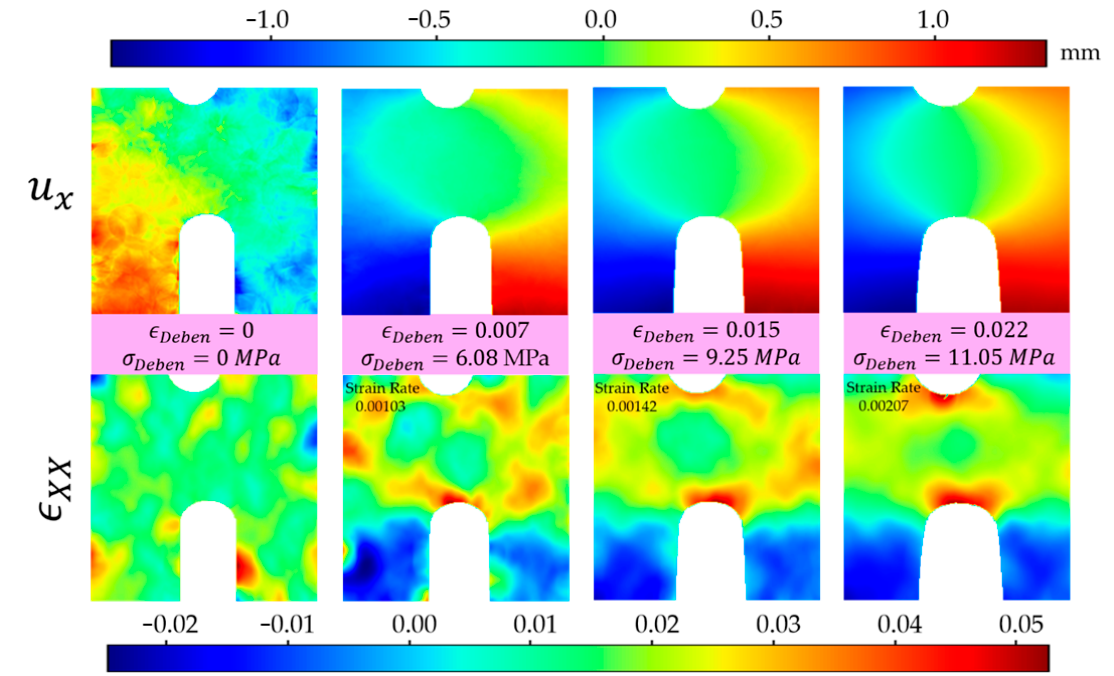
Figure 5. Displacement (top) and stain (below) distribution along X-axis at nominal macro strain values of 0, 0.007, 0.015 and 0.022, respectively.